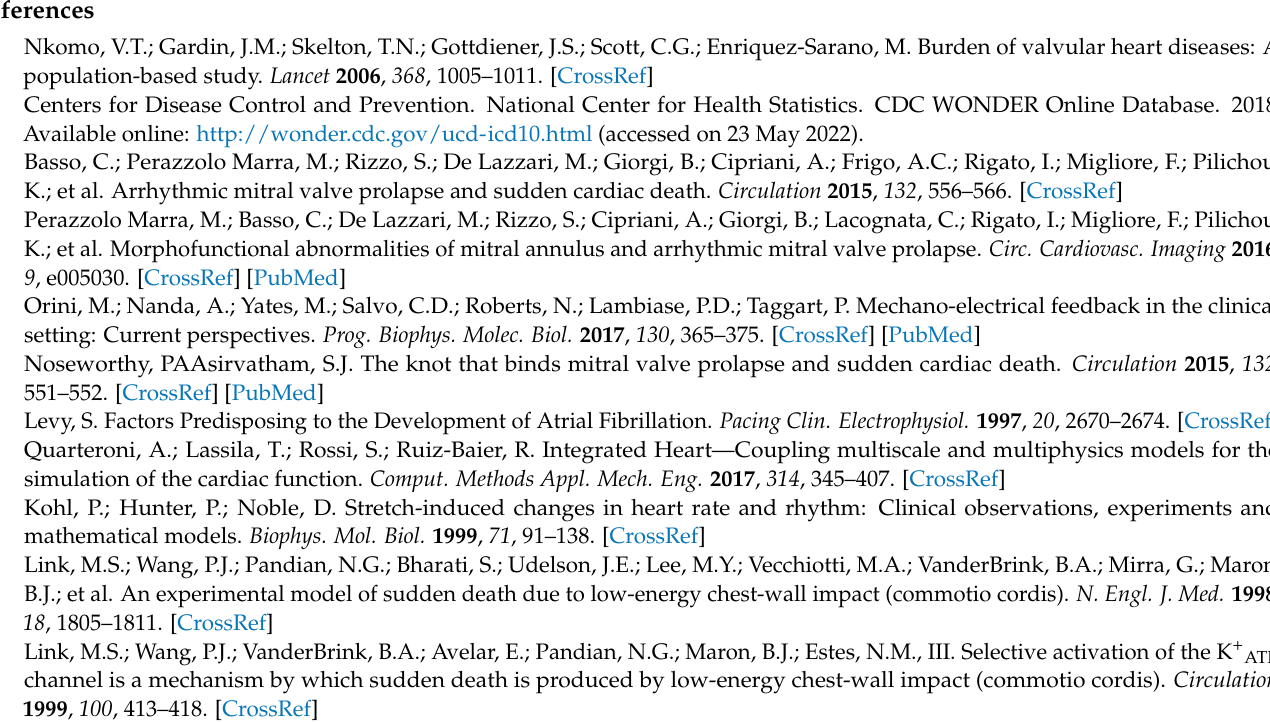
cycle. Figure S2: The effect of increasing µ 1 for the control case: µ 1 = [ 0.0128,0.0145,0.020,0.0268 ] . Figure S3: The effect of increasing µ 2 for the control case: µ 2 = [ 0.153,0.1584,0.1718,0.36,1.8 ]